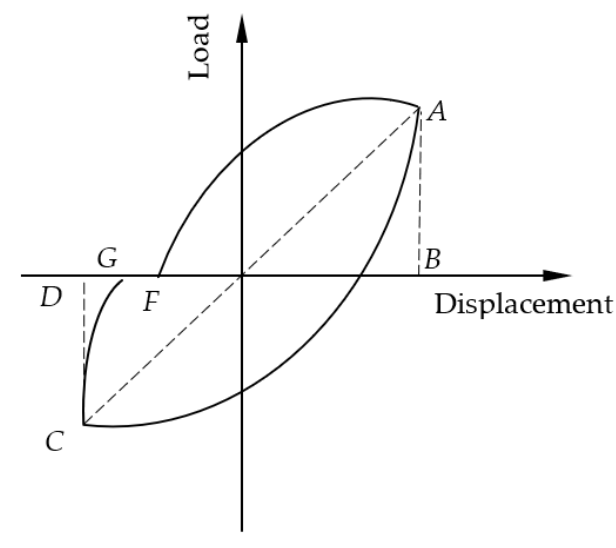
Figure 20. The hysteretic curve energy dissipation coefficient calculation diagram.